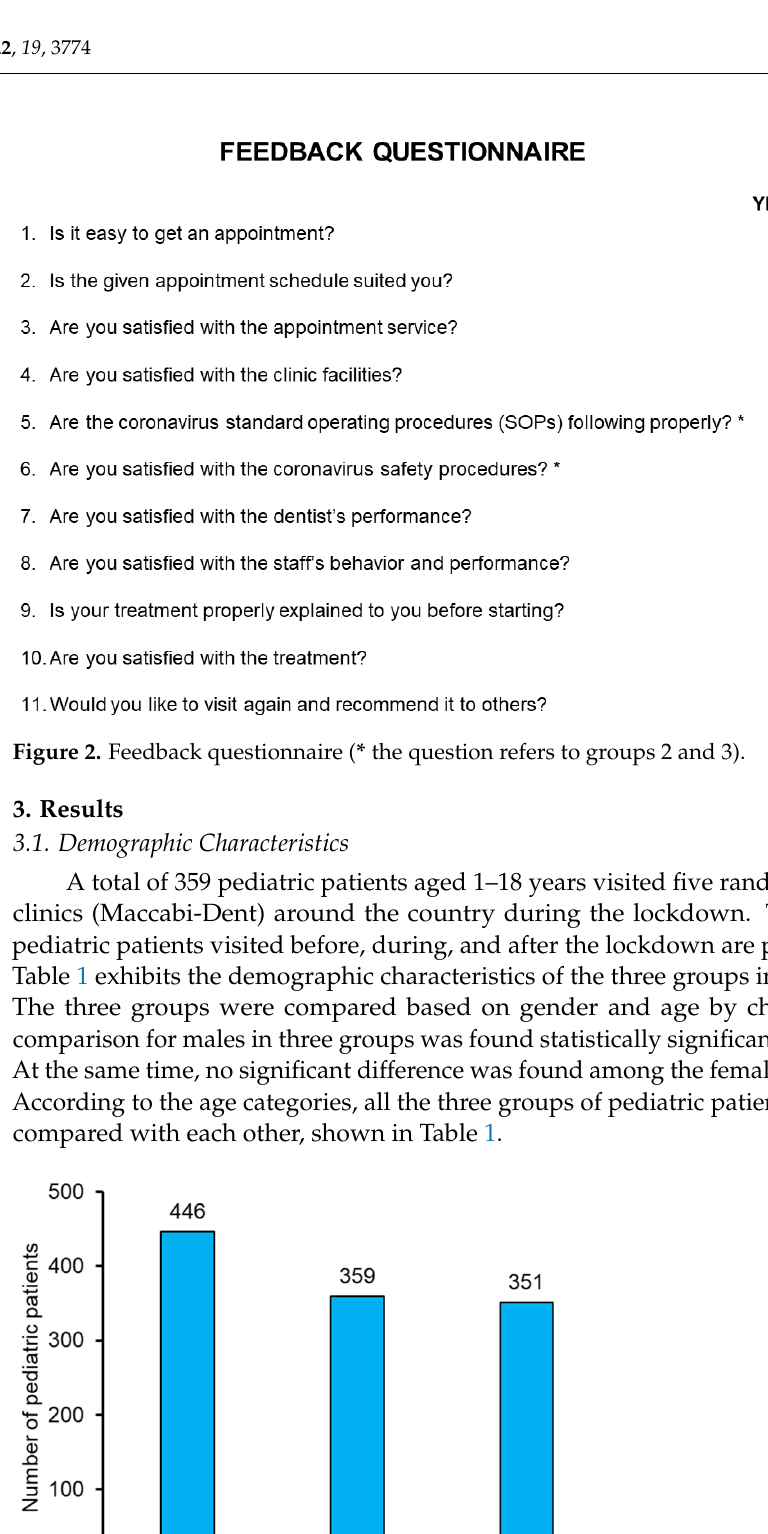
Table 1. Demographic